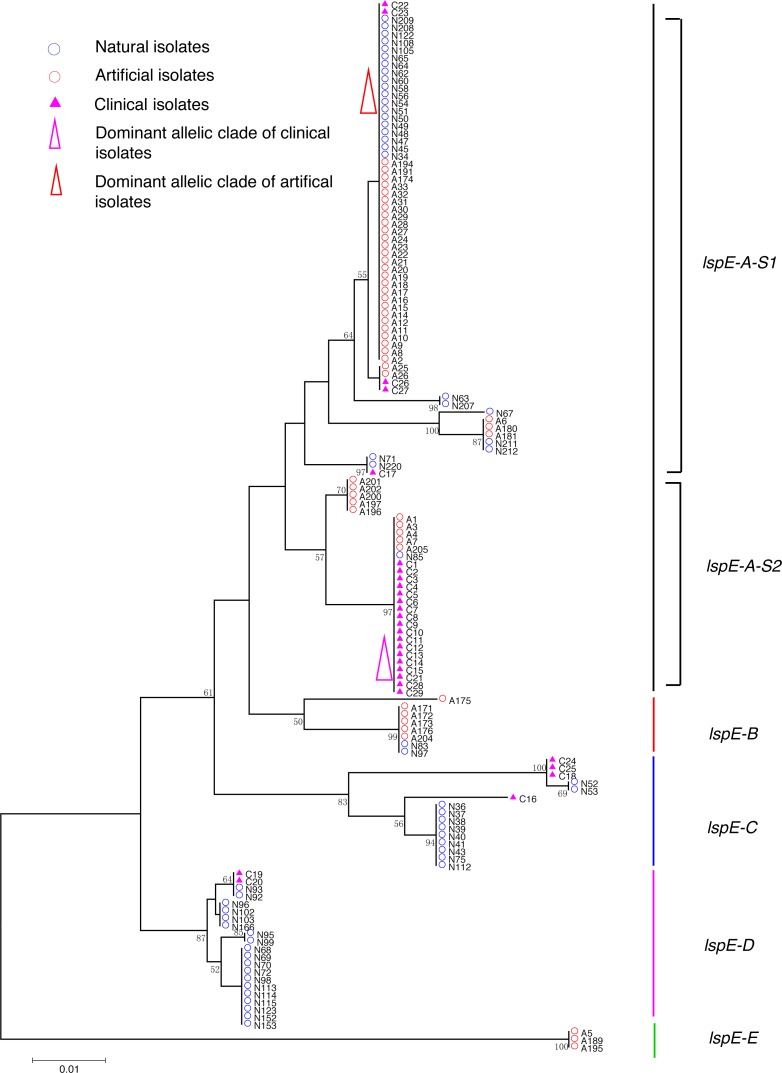
Neighbor-Joining tree of L. pneumophila isolates from DNA sequences of lspE locus.Strain types, source natures and geographic locations of these isolates were shown in Table S1. Bootstrap support values (1,000 replicates) for nodes higher than 50% are indicated next to the corresponding node. Five main groups of the clades could be found.